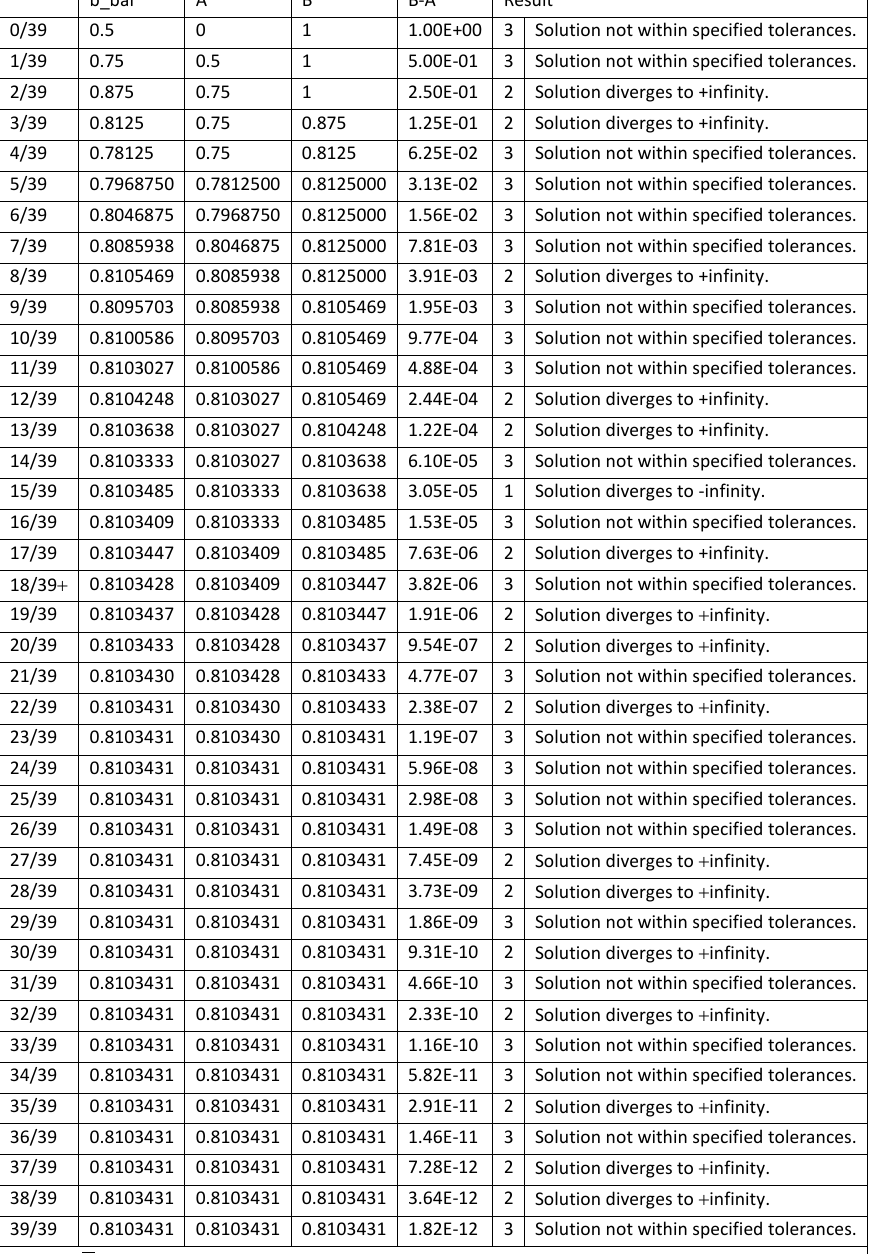
Table 3 Backward shooting method solution, end result: Convergence